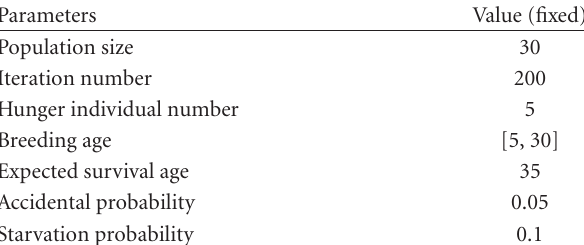
Table 3: Parameters for PA algorithm.